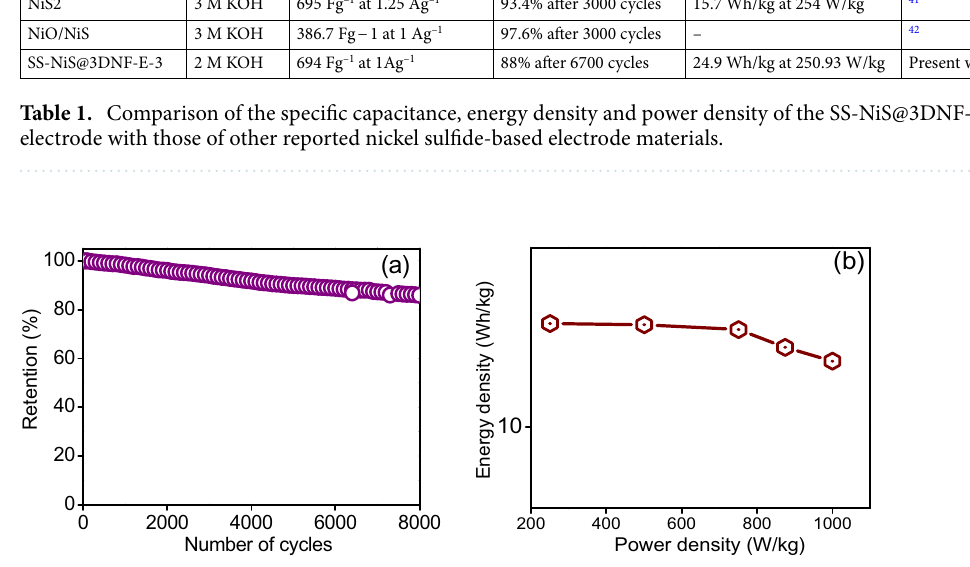
Figure 6. ( a ) Cyclic retention up to 6700 cycles, and ( b ) energy and power density curve of the SS-NiS@3DNF-E-3